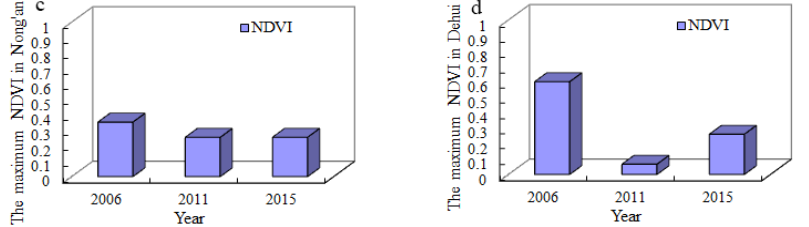
Figure 3. The change of maximum NDVI in different area of Changchun